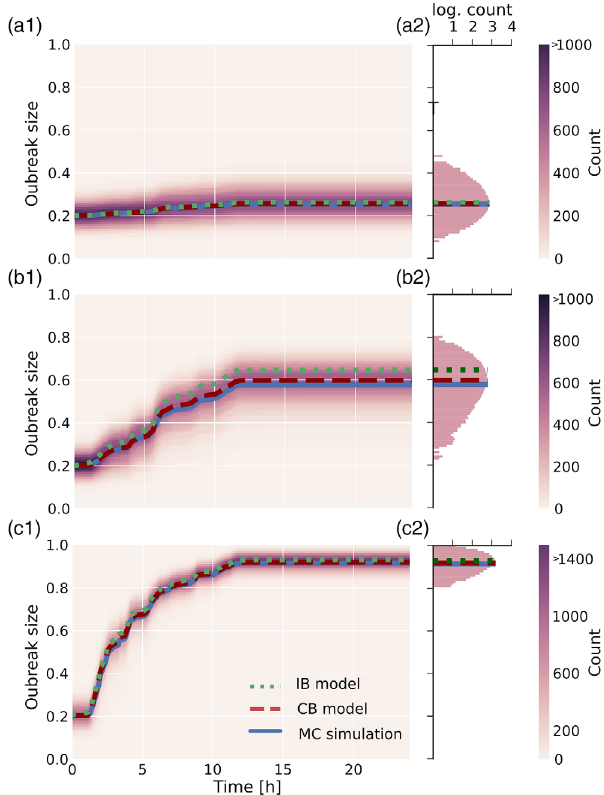
FIG. 16. Cumulative infection probability with a large fraction of initially infected nodes for three different values of β and the same outbreak location as in Fig. 3(a). Left column [panels (a1) – (c1)]: Time-evolving distribution (linear scale) of cumu- latively infected individuals for infection probabilities β ¼ 0 . 01 , 0.02, and 0.1, respectively. We average over outbreak locations with 20% of the network initially infected at random. The mean outbreak size (blue line), averaged over 10 5 realizations and with a standard deviation below 10 − 4 , can thus be compared to the CB and IB models (red dashed and green dotted lines, respectively) with no threshold applied. Right column [panels (a2) – (c2)]: Final distribution (logarithmic scale) together with the averaged values.